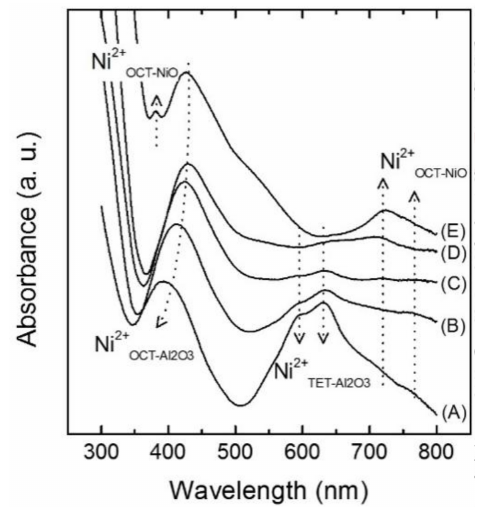
Figure 2. UV-DRS spectra of (A) NiOx / SA-001, (B) NiOx / SA-007, (C) NiOx / SA-028, (D) NiOx / SA-047, and (E) NiOx /